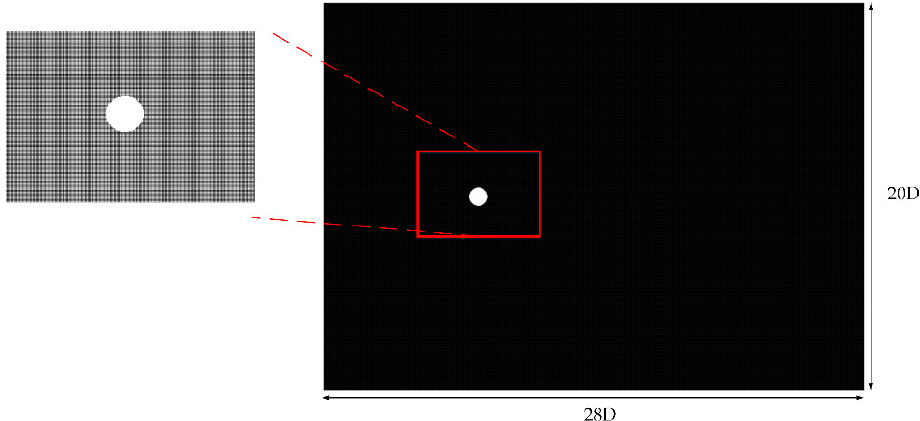
Figure 19. Schematic diagram of the single-level grid around the cylinder in 2D case.